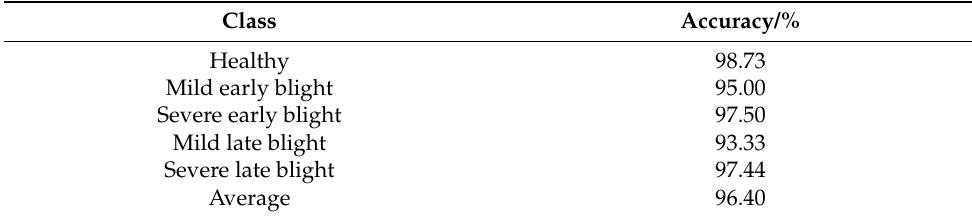
Table 3. Disease classification